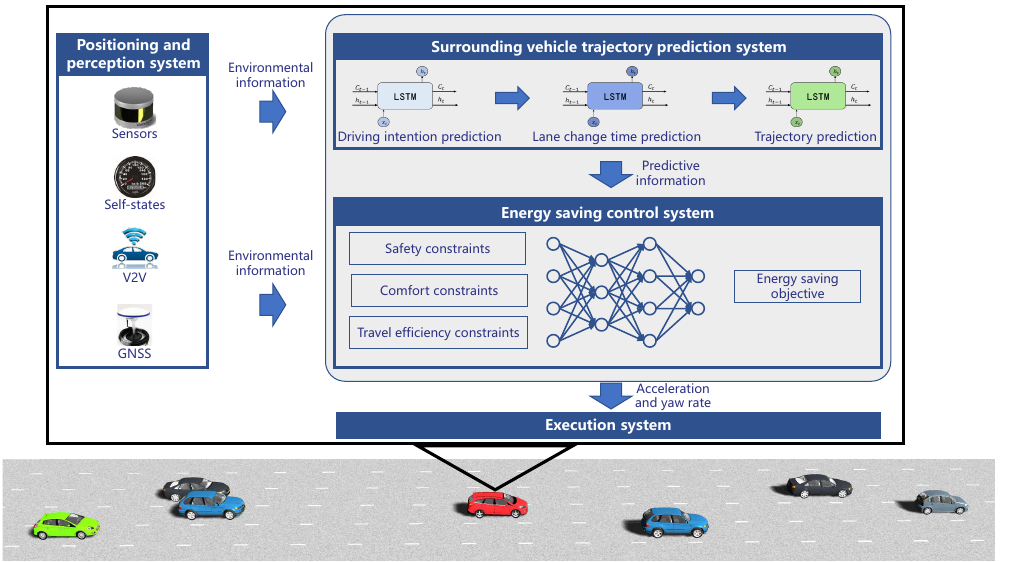
Figure 1. The implementation architecture of the proposed